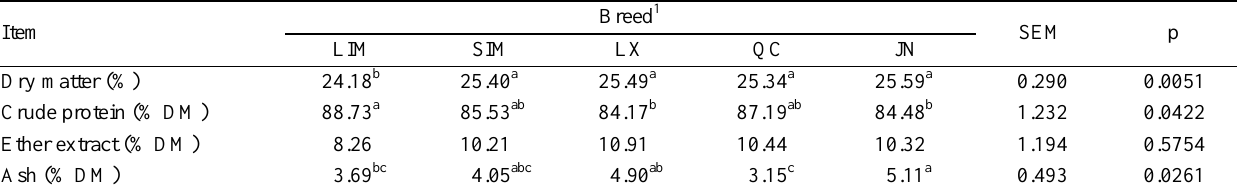
Table 2. Comparison of chemical composition of the cattle breeds Item